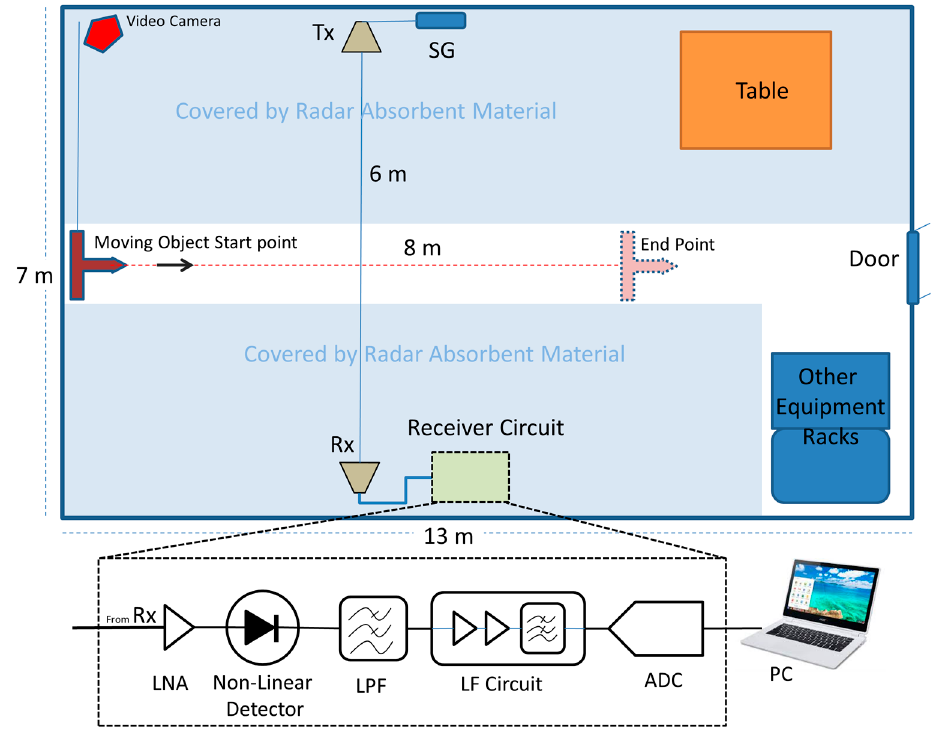
Figure 9. FSR Experimental setup and FSR circuit block diagram.